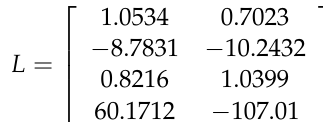
Figure 13. The square root sum of the trajectory tracking error in each direction defines the trajectory tracking error; the end effector trajectory tracking, and error of the right arm are shown in Figure 14. The red line represents actual trajectory, and the blue line represents desired trajectory. The maximum error of trajectory tracking in three directions are 0.02, 0.01, and 0.015, respectively. The trajectory tracking performance of the asymmetric teleoperation system is